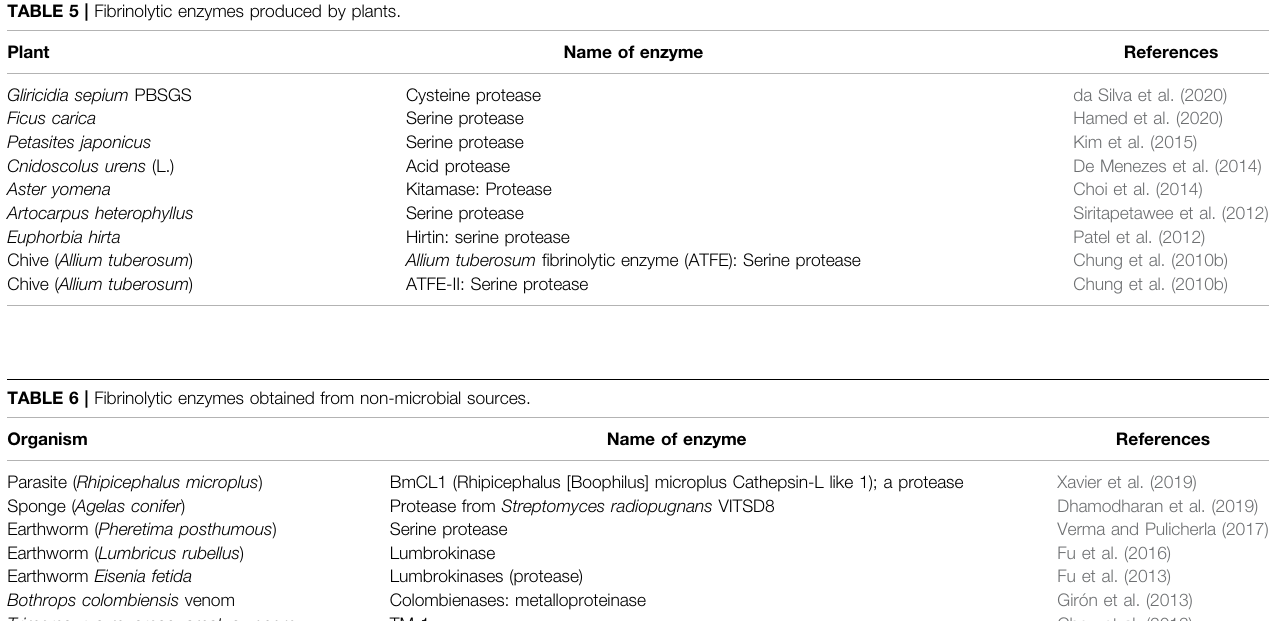
( Table 6 ). Snake venom metalloproteinases (SVMPs) are classi fi ed into four groups (PI to PIV) based on their domain structures. PI